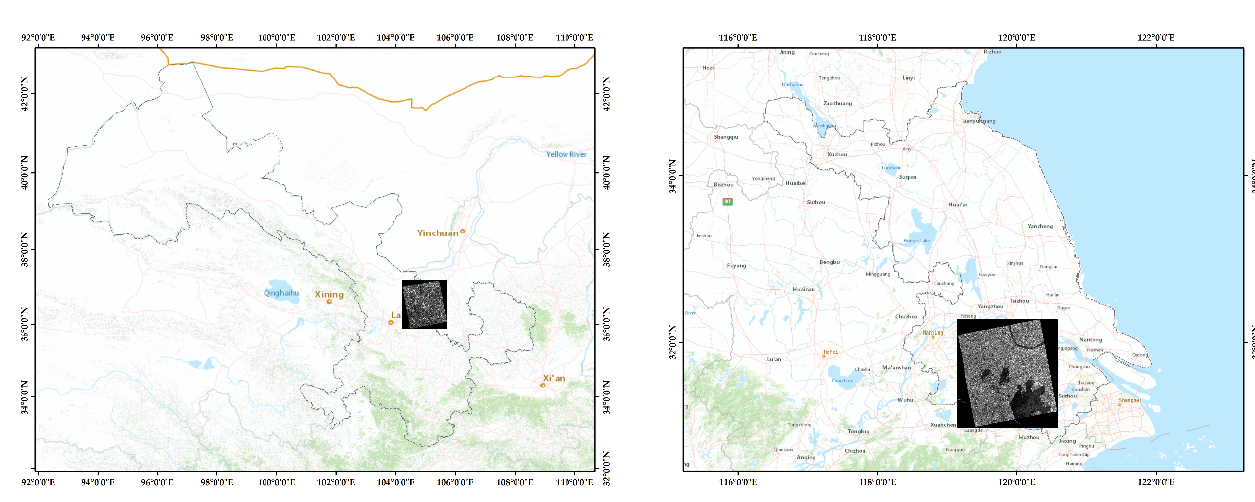
Figure 6. Google Earth images, SAR images, and labels of the dataset: ( a ) Urban areas, ( b ) rural areas, ( c ) strip-shaped buildings, and ( d , e ) negative samples. White and black on the labels represent built-up and non-built-up areas, respectively.